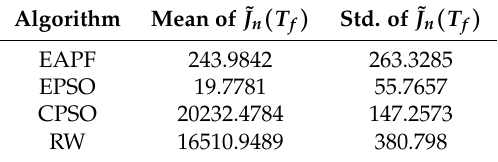
Figure 6. Evolution of the estimated gas distribution map in the outdoor environment generated by the n ∗ th robot in each simulation at three instants in time, where the red point indicates the position of the n ∗ th robot and white points indicate the other robots, where the sub-figures in the first row ( a – c ) show the evolution of the estimated gas distribution obtained by the EAPF algorithm; the sub-figures in the second row ( d – f ) show the evolution of the estimated gas distribution obtained by the EPSO algorithm; the sub-figures in the third row ( g – i ) show the evolution of the estimated gas distribution obtained by the CPSO algorithm; and the sub-figures in the fourth row ( j – l ) show the evolution of the estimated gas distribution obtained by the RW algorithm. Table 3. Statistic results of the approximated cost function at the final time step in the outdoor